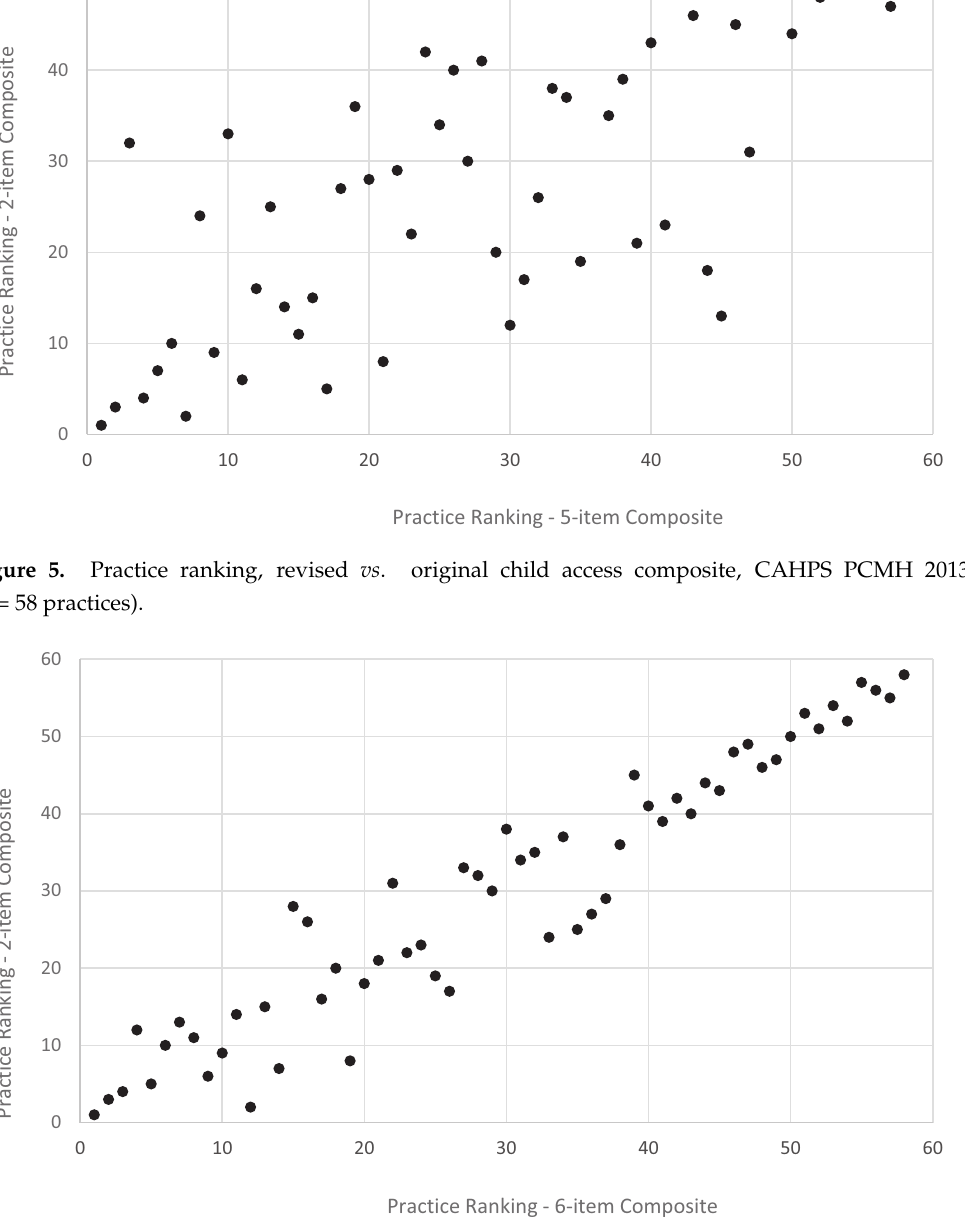
Figure 6. Practice ranking, revised vs . original child communication composite, CAHPS PCMH 2013 ( n = 58 practices).